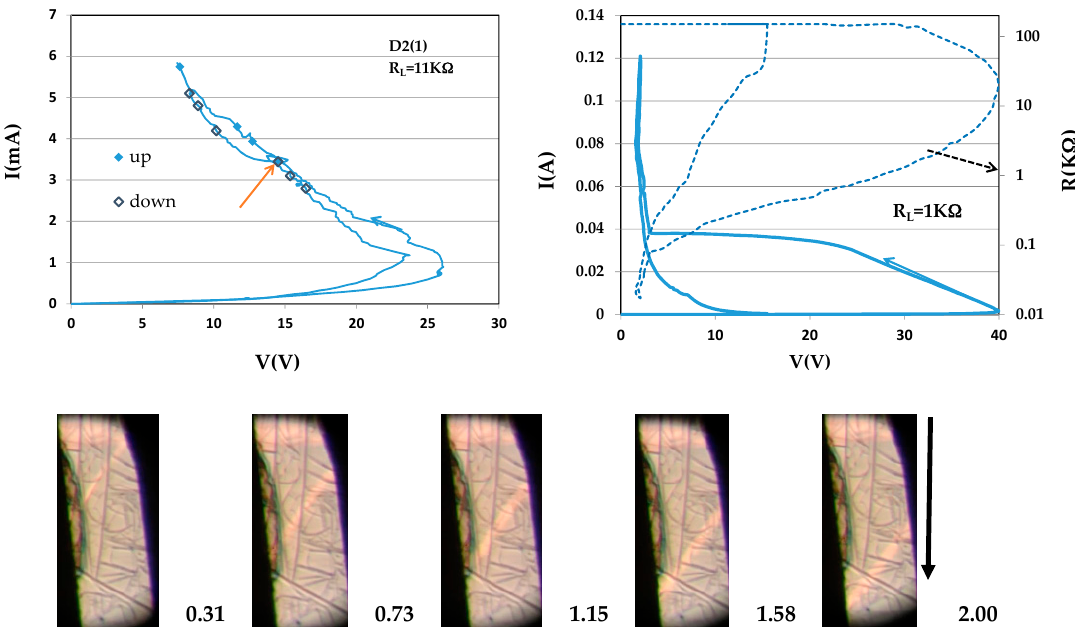
Figure 3. I–V characteristics for sample D2(1) with two load resistances. The images of sliding domains were snipped from the video 0.4 s apart at the point on the loop at left marked by the arrow. Additional sequences were obtained at the points marked on the loop for increasing and decreasing currents. The arrow marks the direction of the electric current.